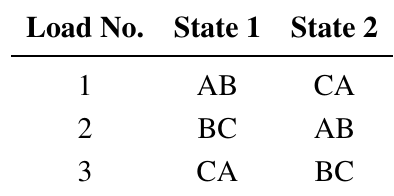
Figure 3. Simplified circuit topology of the direct matrix converter and the power router attached to its output. Both are three-phase input/output systems. The switch groups for state 1 and 2 of Table 1 are also obvious. Table 1. State 1 is the steady state before switching. Each load is fed with a different phase-to-phase voltage after switching (State 2). AB, BC, and CA refer to the phase-to-phase